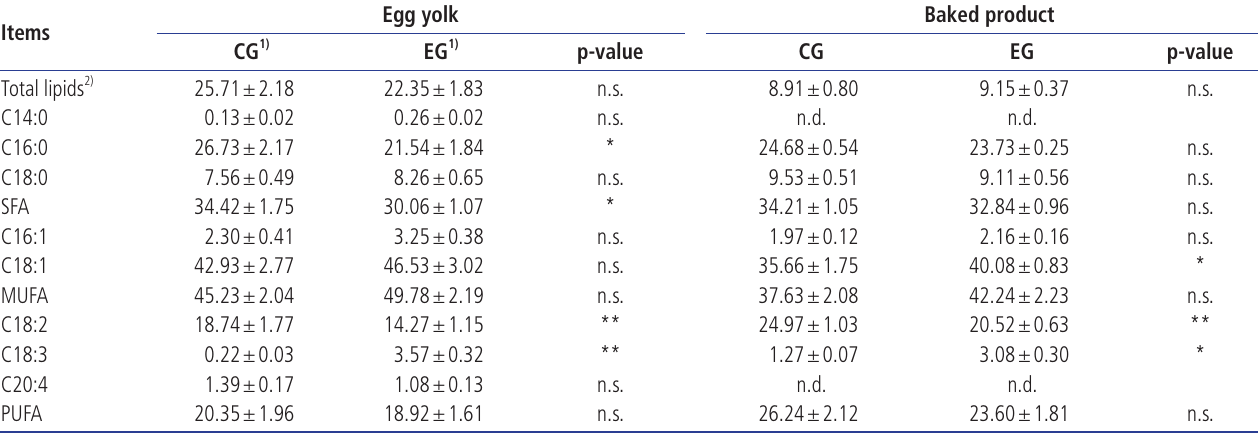
Table 4. Total lipids and fatty acid profile of egg yolks and baked products obtained from control and experimental group